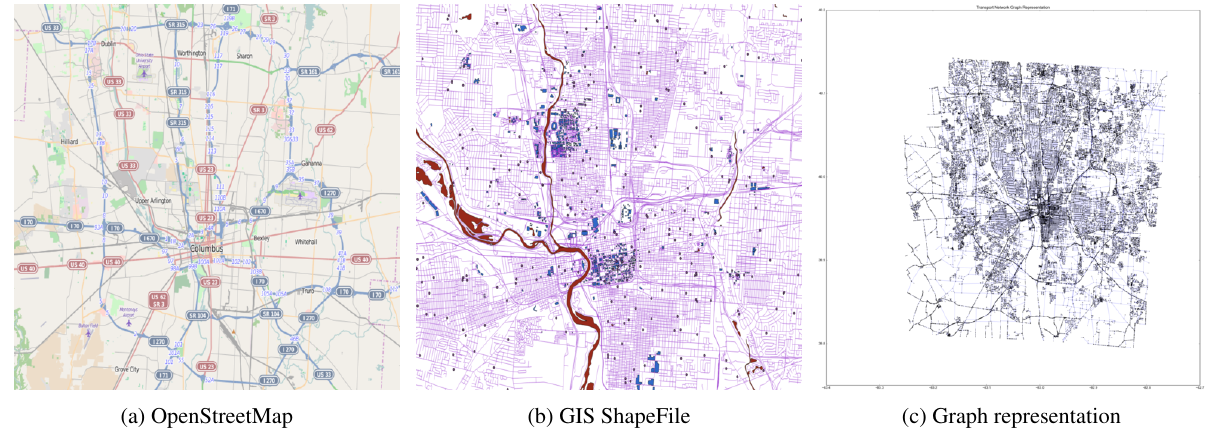
Figure 2: Abstraction of OpenStreetMap or GIS data to a transport network Graph representation